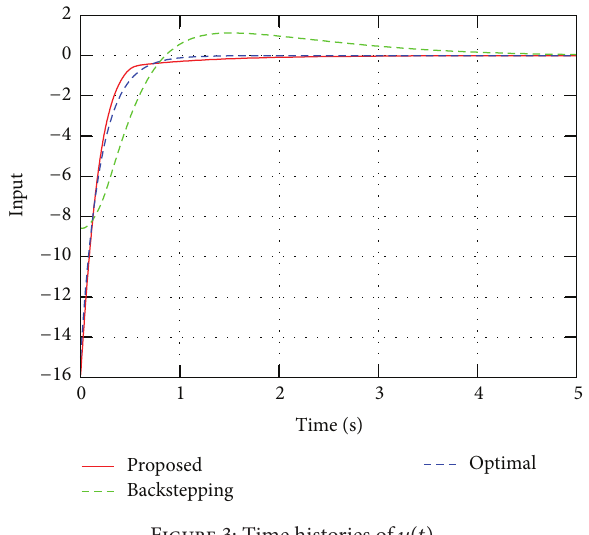
Figure 3: Time histories of 𝑢(𝑡) .